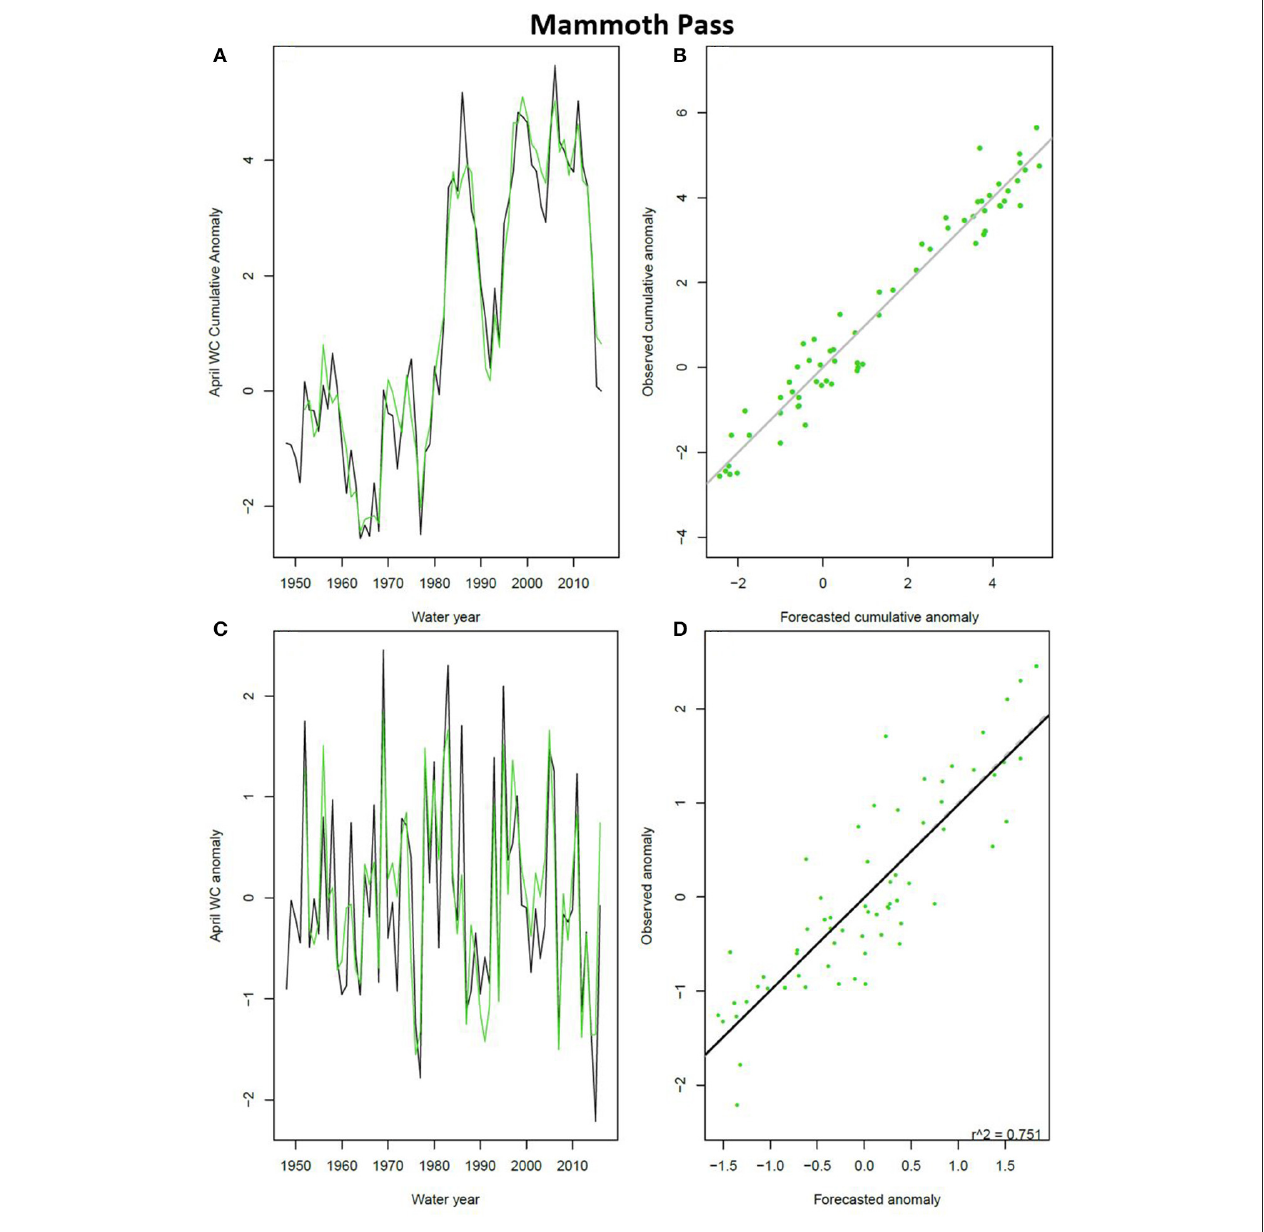
FIGURE 3 | VECM model predictions for Mammoth Pass, using the final parameters. (A) Cumulative April 1 SWC anomalies; (B) Scatter plot of the data in panel A; (C,D) As in panels (A,B) but for the anomalies (not cumulative). Time series lines in black are observed data. Green lines and points indicate VECM model forecasts